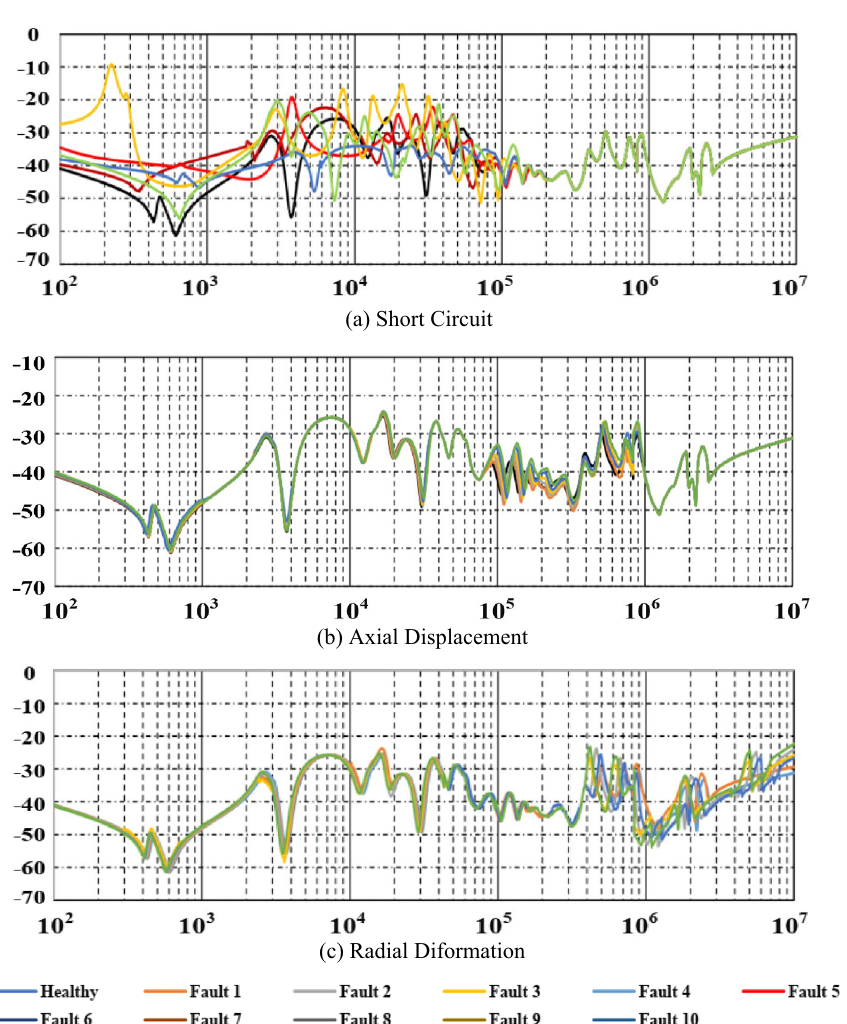
Figure 5. The effect of RD, AD, and SC defects in FRA for different levels of